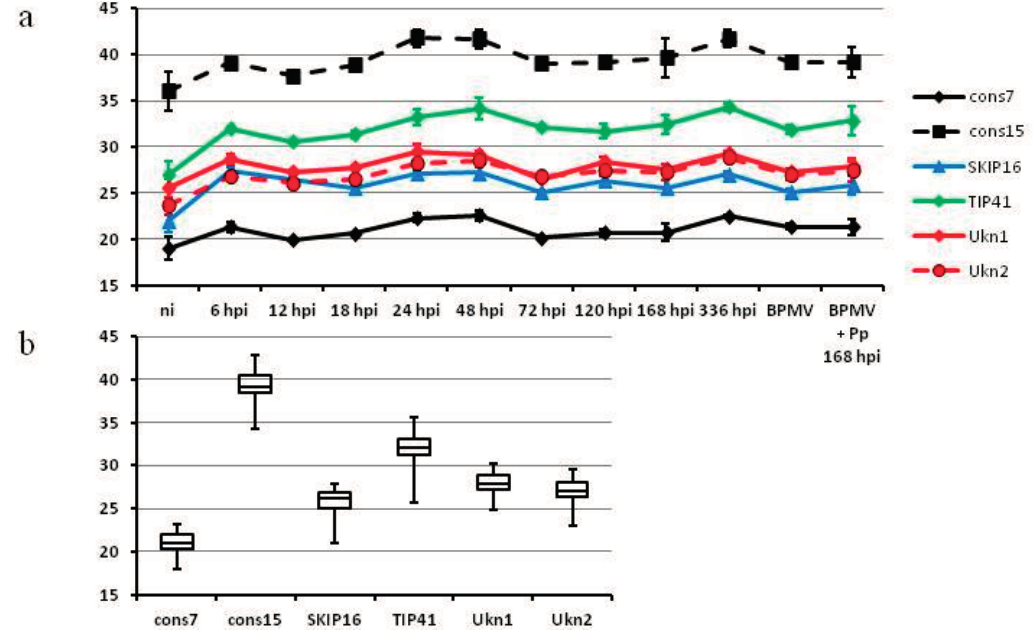
Figure 3. Variation of C q values for G. max candidate reference genes between samples (vertical axis: C q). ( a ) Average and standard deviation of C q values for every sample; ( b ) box plots representing the range of C q values; For better representation of RNA abundance the C q values were corrected for primer efficiency: C q corr = lg 2 ((2 × e) C q ).